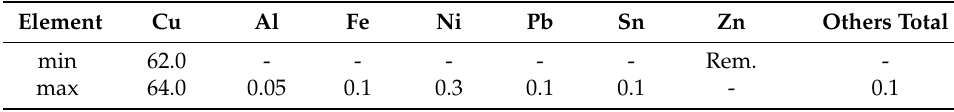
Table 3. Physical properties of tungsten Table 3 . Physical properties of tungsten carbide .